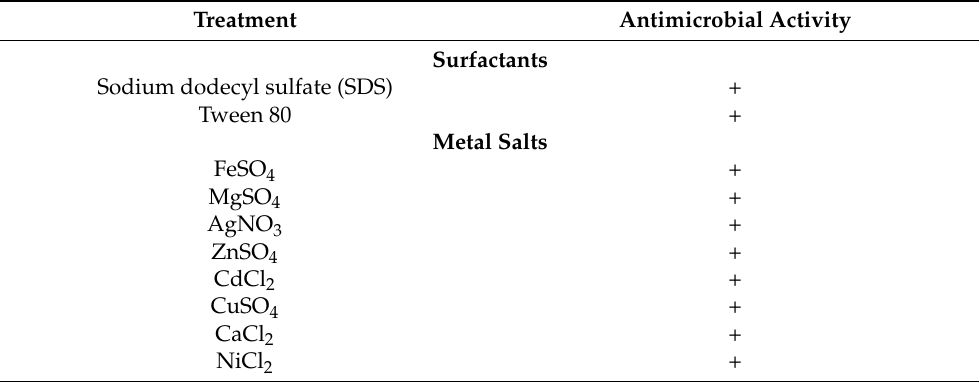
Table 5. Effects of surfactants and metal salts on the antimicrobial